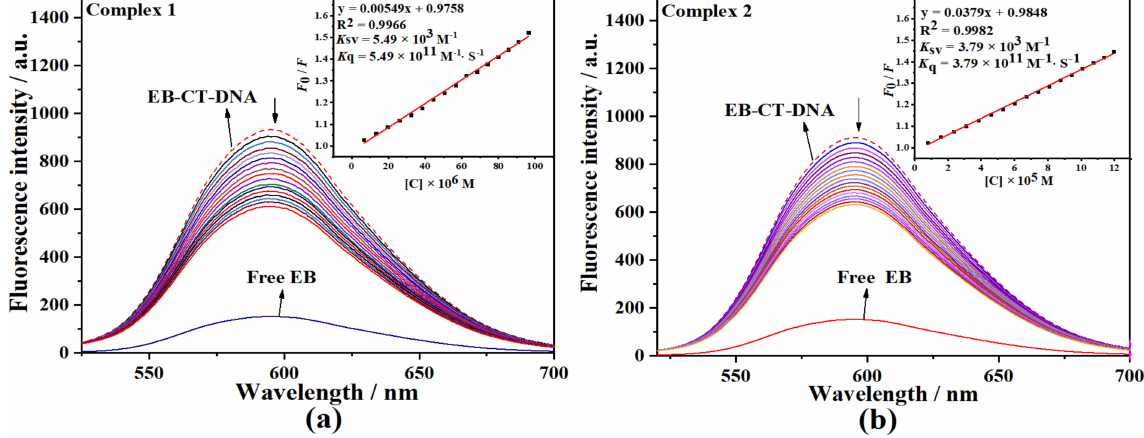
Figure 3. EB-DNA emission spectra in the absence or the presence of complex 1 ( a ) and complex 2 ( b ). Inset: F 0 / F vs. [C] plots. Arrows indicate the changes in intensity of fluorescence with escalating complex